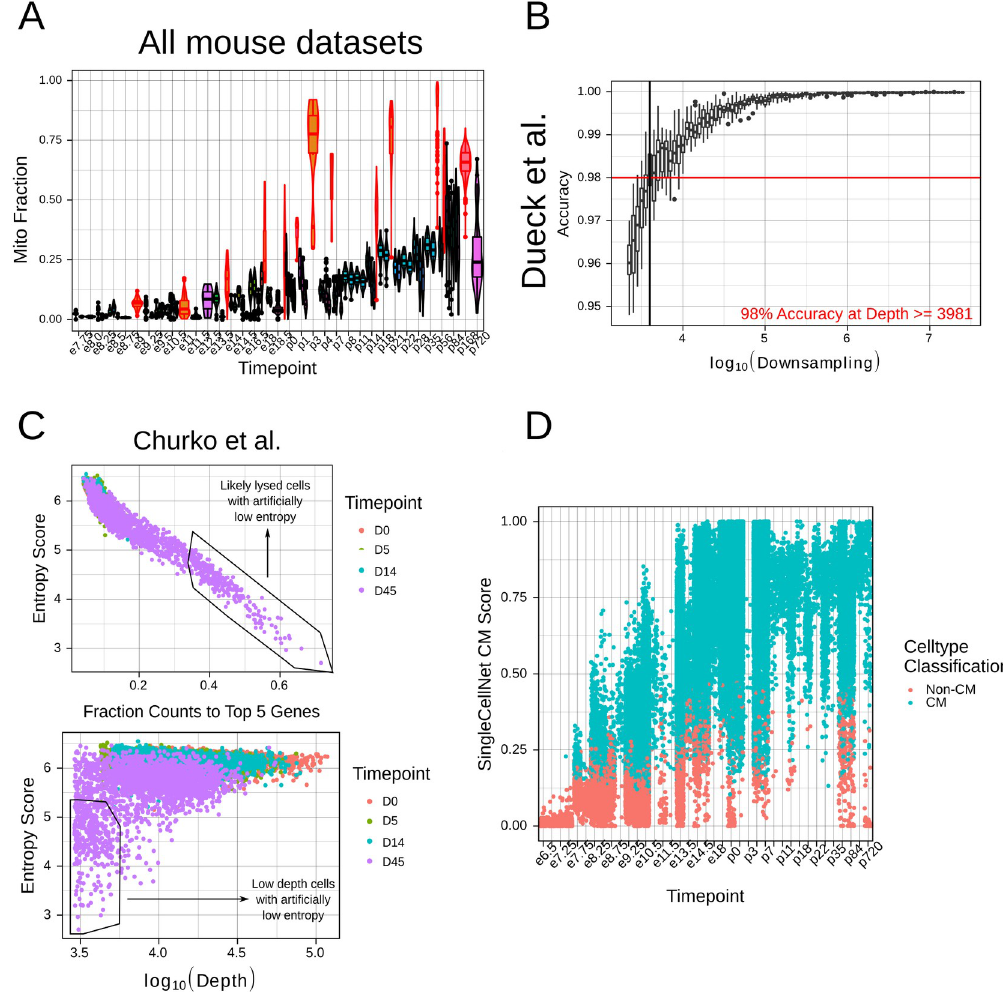
Fig 3. Standardized cell and study filtration enables meta-analysis of CM maturation with entropy. A. Mitochondrial gene fractions in mouse in vivo datasets. Datasets with unusually high proportions are highlighted in red and were removed from subsequent analysis. B. Subsampling of count depth in Dueck et al. dataset (the highest depth dataset in our analysis). We subsampled to a depth where the median number of genes remained > 1000. We subsequently computed the accuracy as deviation from baseline entropy. C. Unusually low entropy cells due to high top 5 gene percentage (top) or low depth (bottom) in the Churko et al. dataset. D. SingleCellNet CM scores for mouse in vivo datasets by timepoint. Cells are labeled based on whether their highest classification was for “cardiac